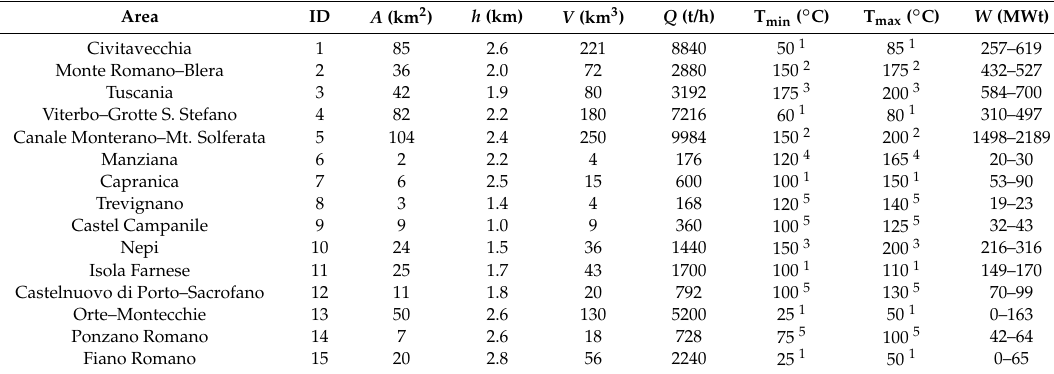
Table 2. Evaluation of fluid production rate (t/h) and theoretical geothermal potential (MWt) [13,20] calculated through the revised volume method of [14] for the VCVD and the